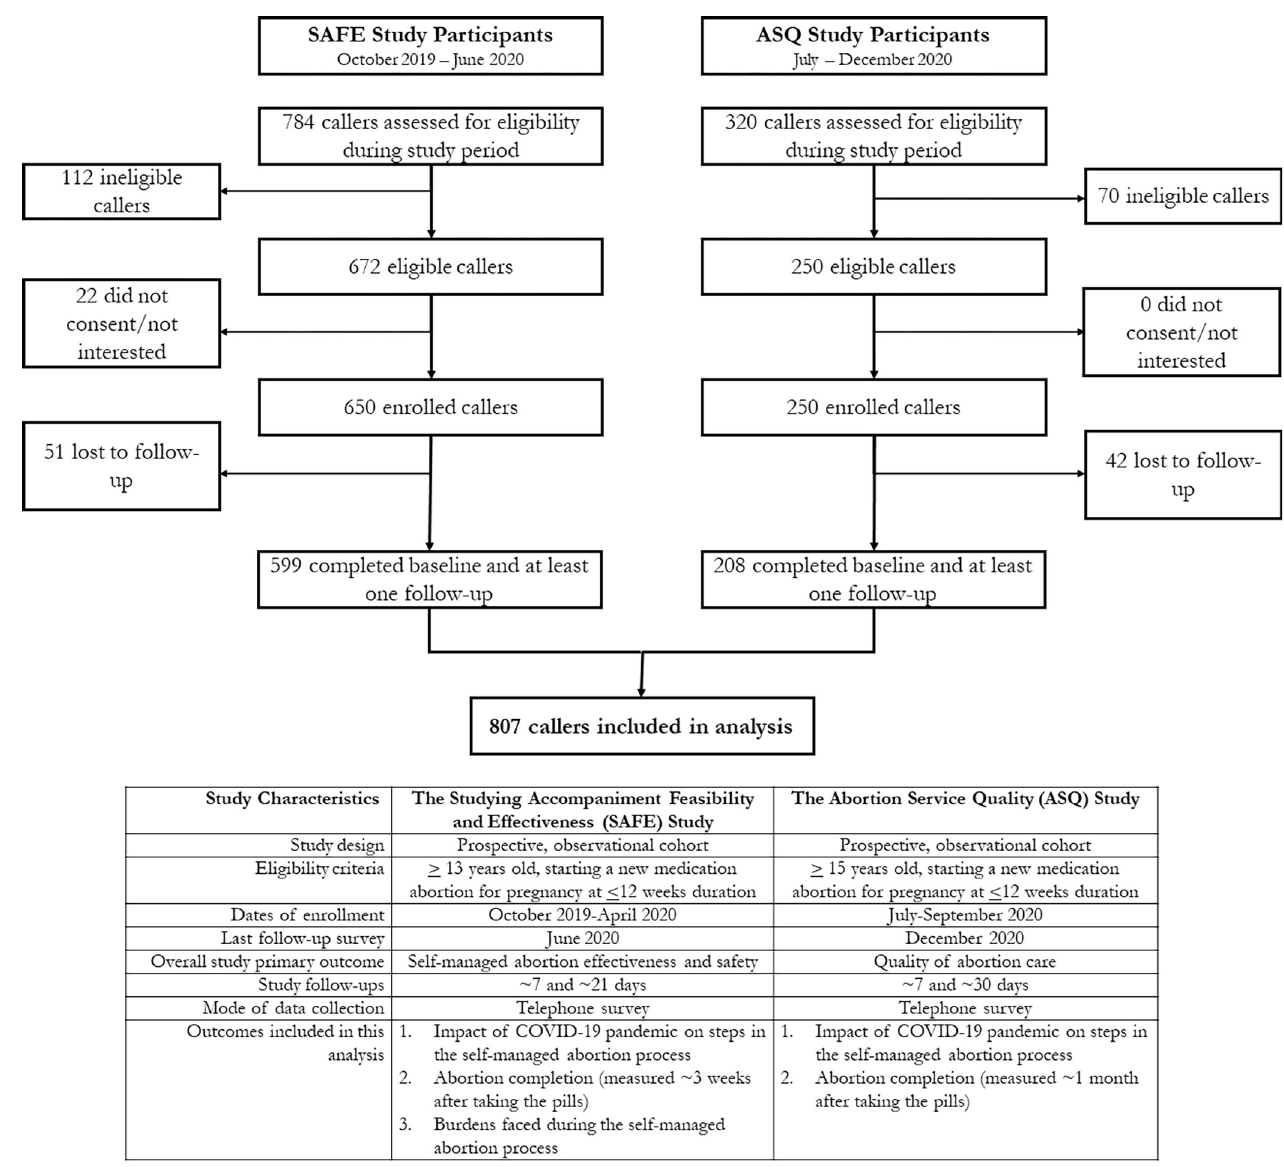
Fig 1. Screening and recruitment of callers to a safe abortion hotline in Nigeria for the ASQ and SAFE